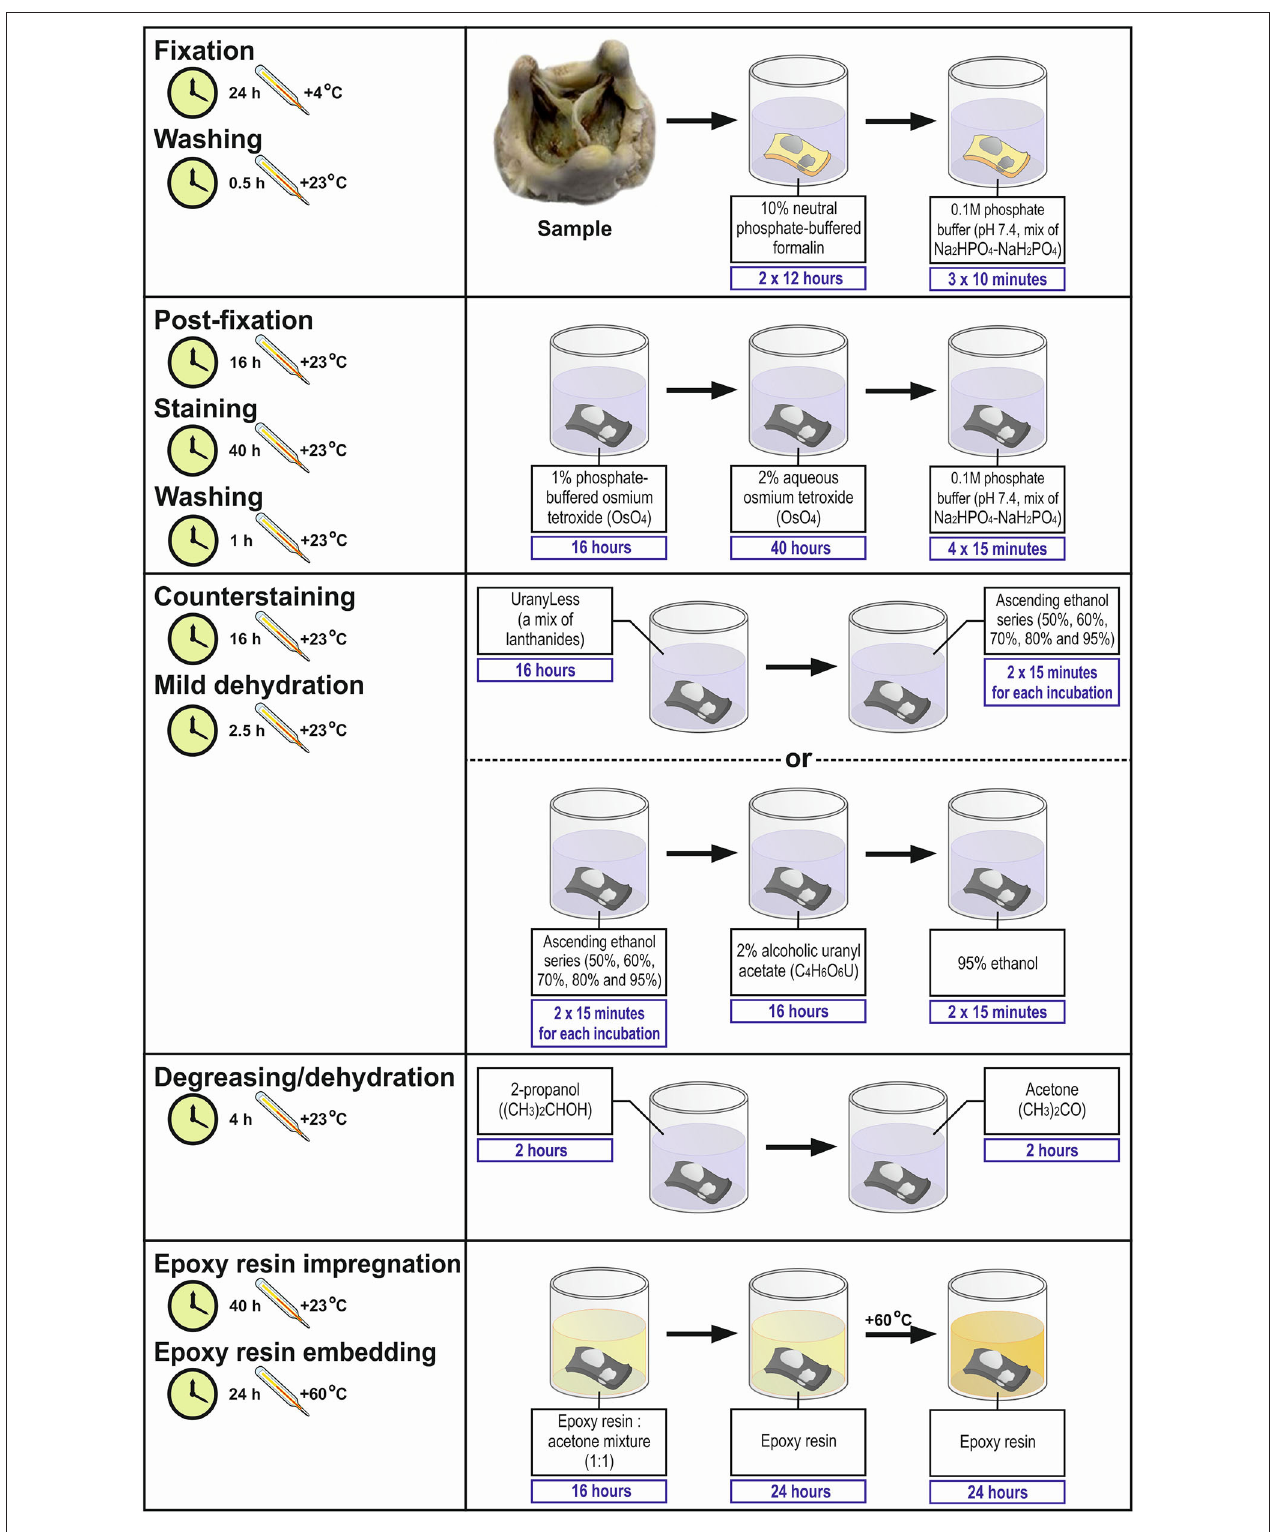
FIGURE 2 | Workflow diagram for Embedding and Backscattered Scanning Electron Microscopy (EM-BSEM) from fixation to epoxy resin embedding.